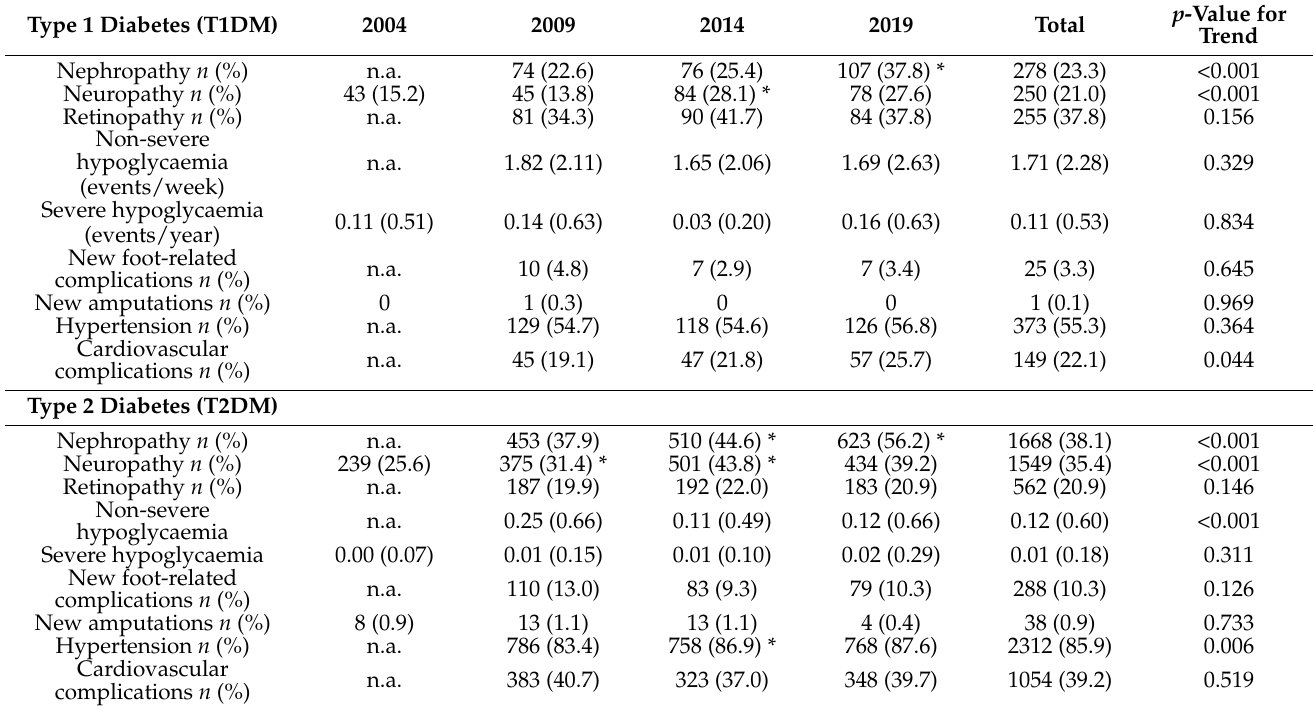
Table 3. Diabetic complications and comorbidity of patients in secondary care (SC).